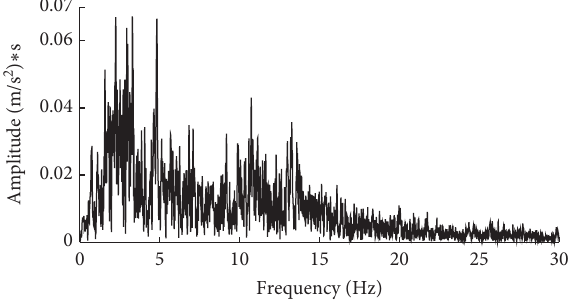
Figure 4: Power spectrum of Wenchuan